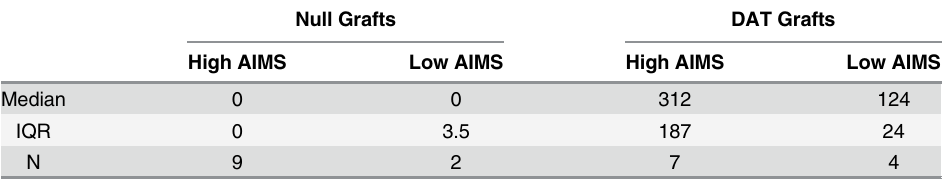
Table 2. Numbers of DAT-immunoreactive cells in grafted rats * .